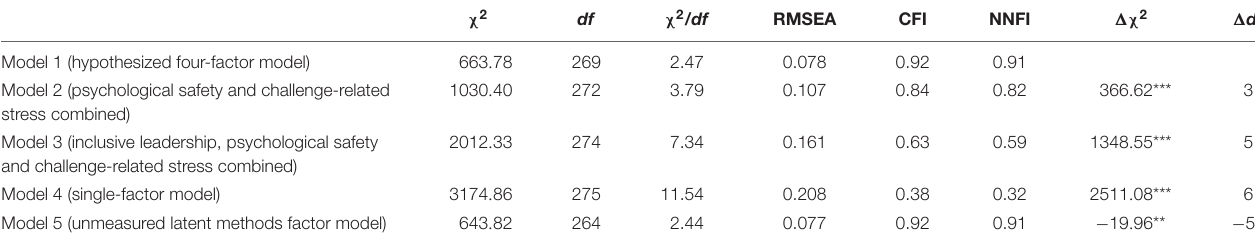
TABLE 1 | Results of confirmatory factor analyses.